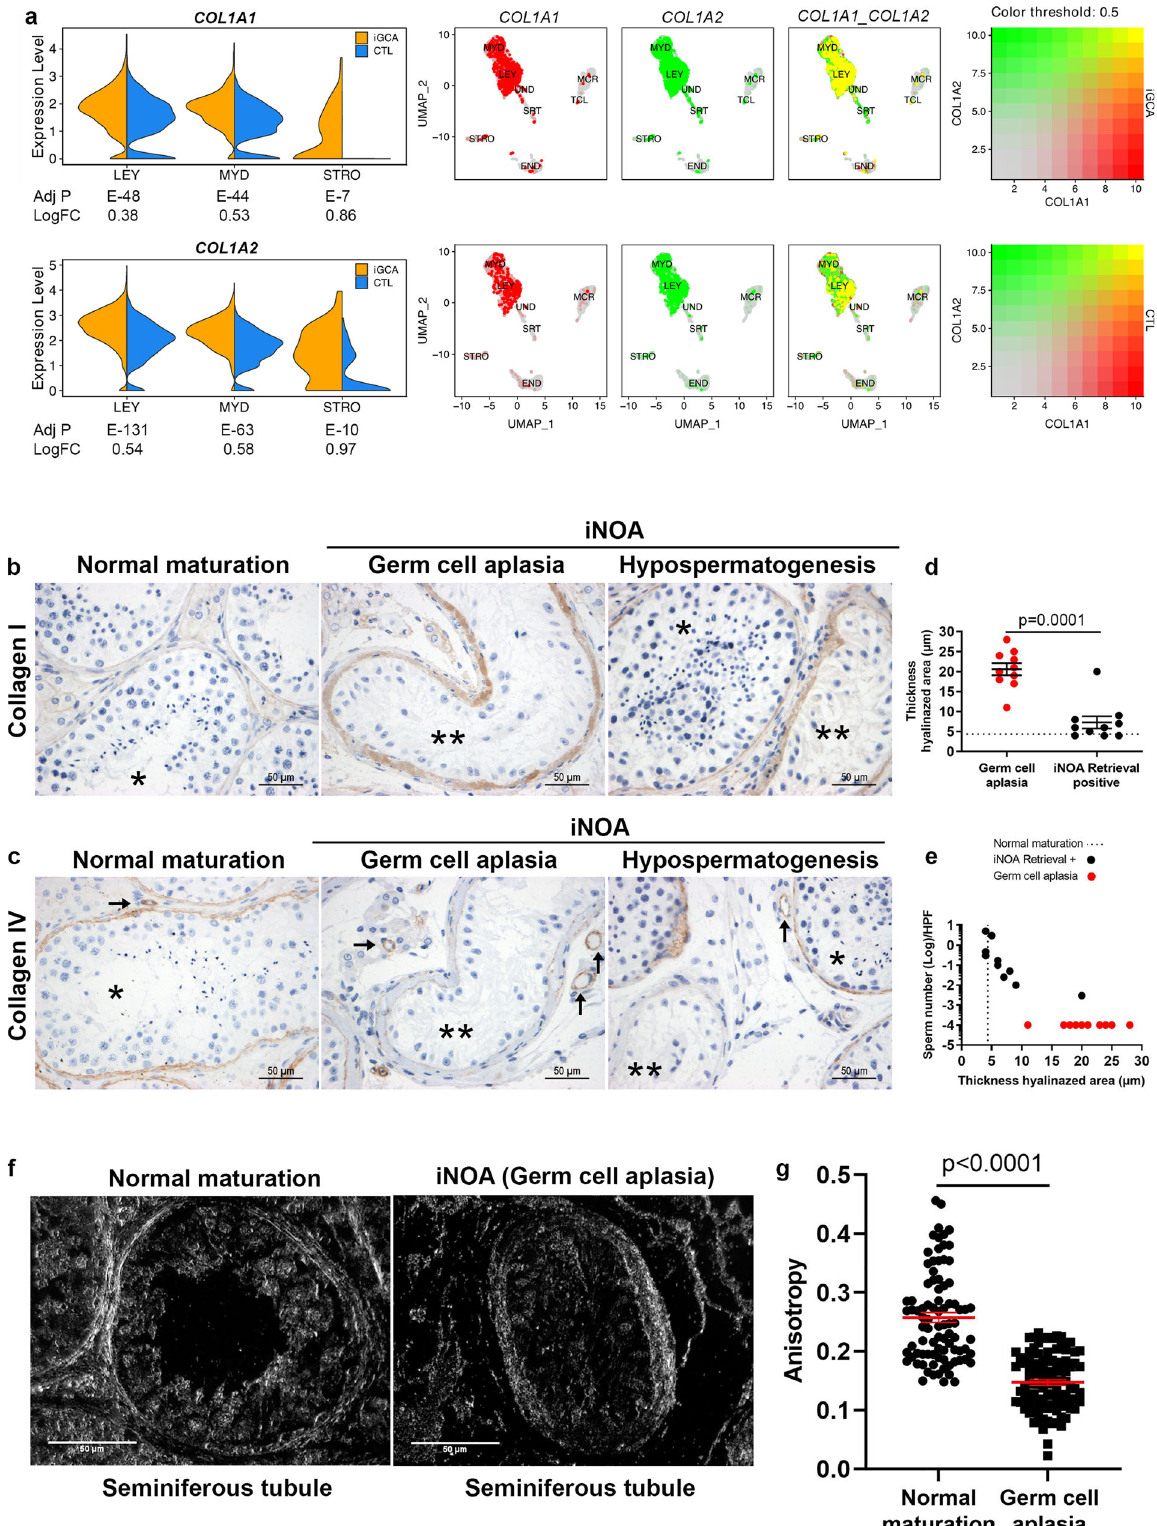
Prompted by the overexpression of cytokines and chemokines in TCL, we quanti fi ed blood circulating CCL4 and CCL5, which belong to the SASP proteins secreted in in fl ammation and senescence. In iNOA men with iGCA vs. age-matched controls, levels of CCL4 and CCL5 chemokines are signi fi cantly higher (Fig. 6h,